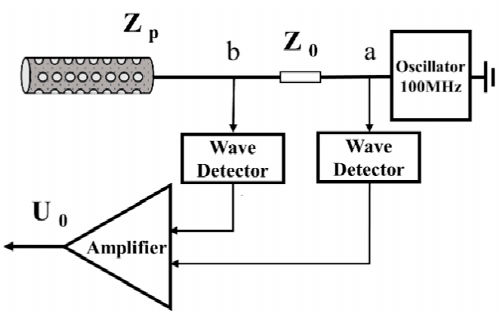
Figure 2. Schematic diagram of measurement circuit, Z 0 , balance impedance, U a and U b , output voltage of point a and point b, respectively. U 0 , amplified di ff erential output voltage between point a and point b.